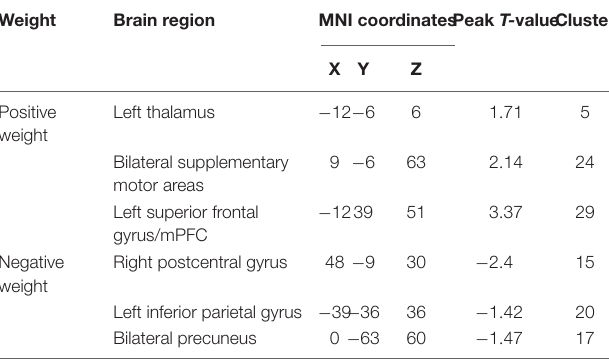
TABLE 4 | The regions’ weight in predicting the treatment effect of taVNS in patients with